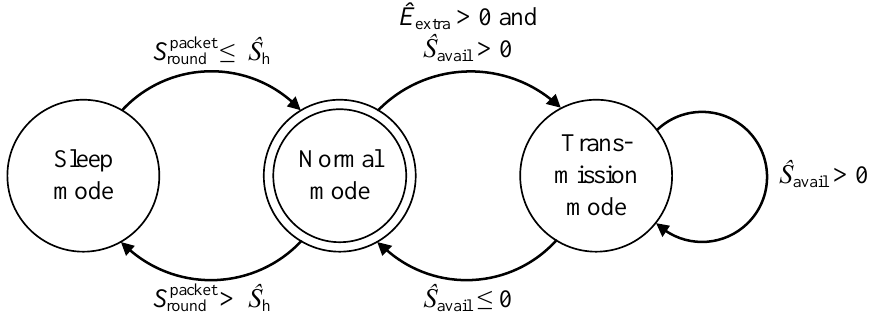
Figure 3. State transition diagram of node operations.